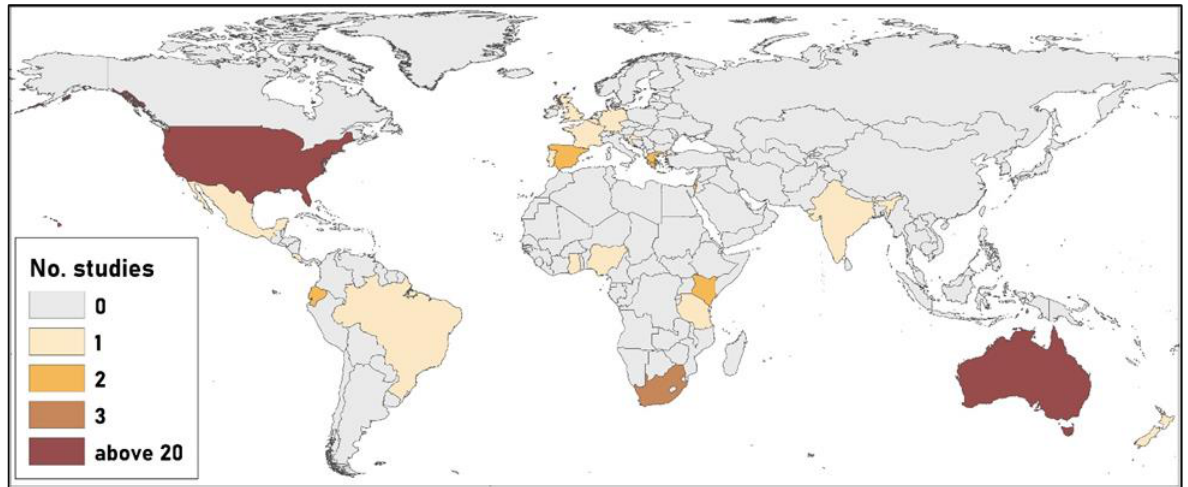
Figure 2. The distribution (by percentage number of papers, n = 69) of researches by countries which reported ungulate impacts on/interactions with reptiles. The remaining four papers are accounted for the review studies which did not specify the geographical location of the